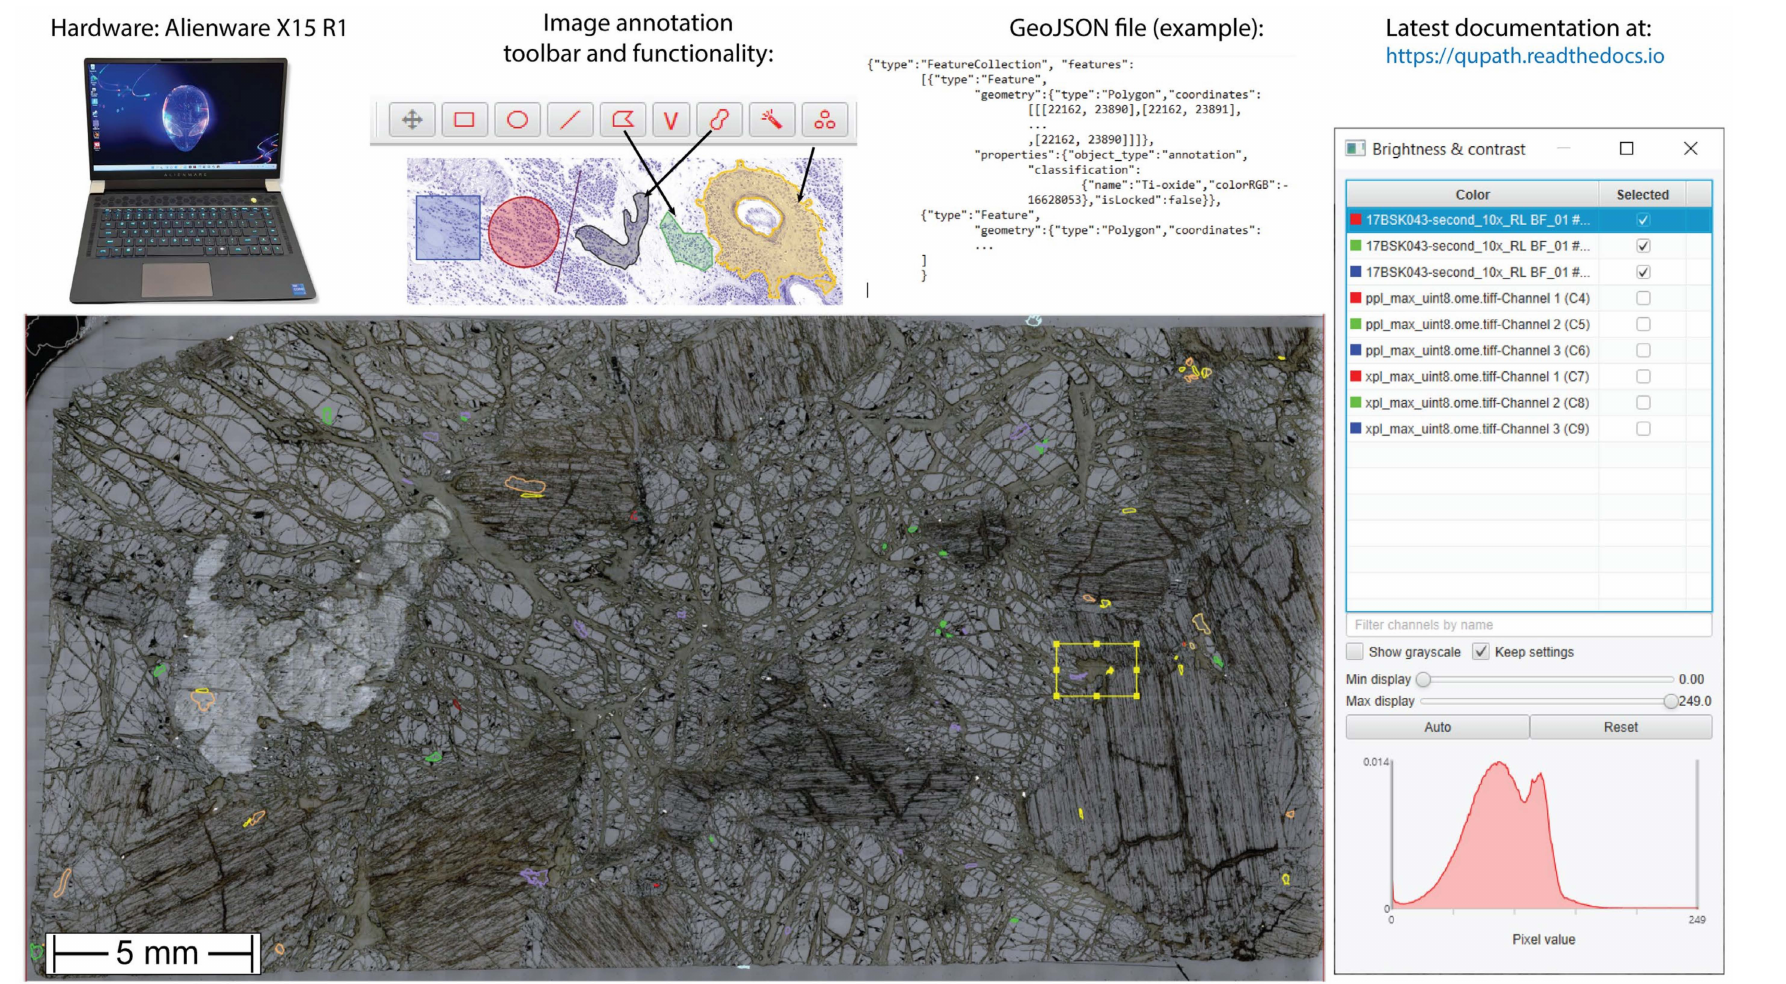
Figure 6. QuPath image annotation on a powerful laptop ( top-left ) using the user-friendly annotation toolbar to generate internal GeoJSON files ( top-centre ) that describe the drawn polygons for the selected RL γ -boosted image (main picture). The tools use the visible layers ( right panel ) that can be toggled for convenience, helping the ‘wand’ tool for precise contouring of grains. The yellow square shows the field of view of Figure 7. Sample: harzburgite